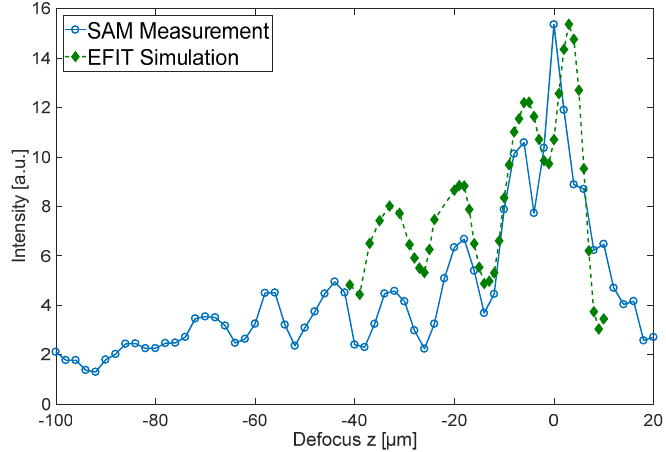
Figure 6. EFIT simulation (diamonds) and SAM measurement (circles) of I ( z ) for the aluminium bulk sample at 430 MHz.